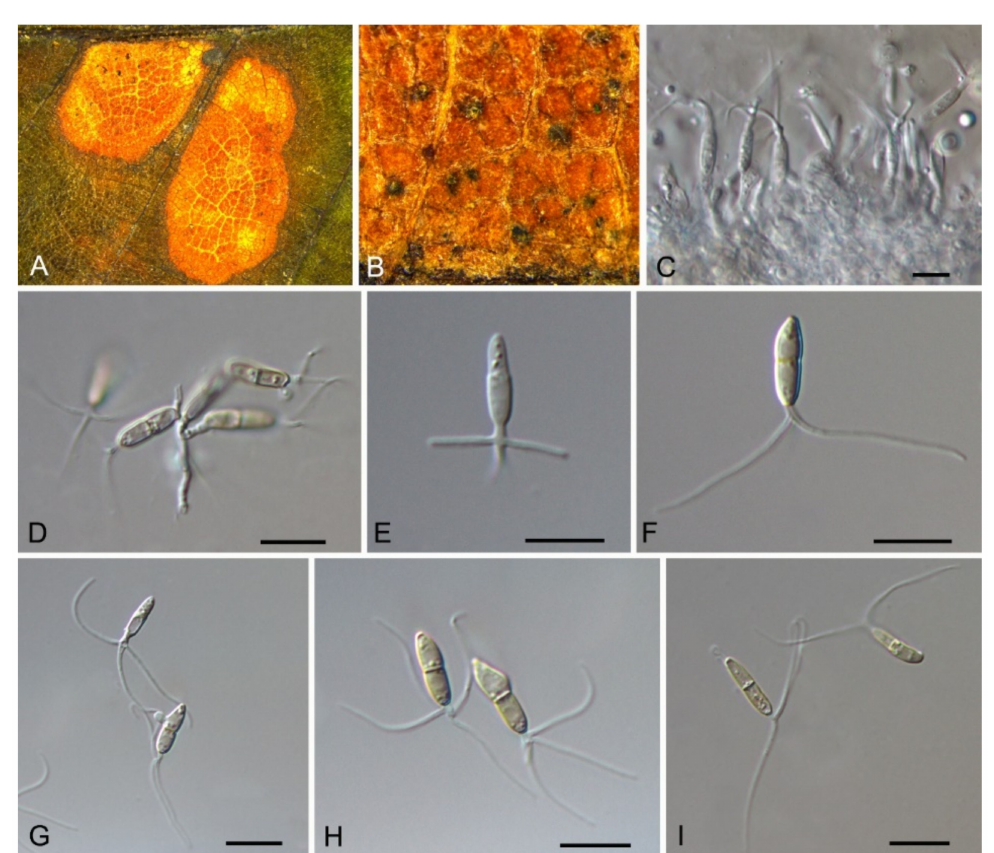
Figure 20. Robillarda sessilis (BJFC-S1804). ( A , B ) Conidiomata on the diseased leaves of Castanea mollissima ; ( C , D ) Conidio- genous cells giving rise to conidia; ( E – I ) Conidia. Scale bars: ( C – I ) = 10 µ